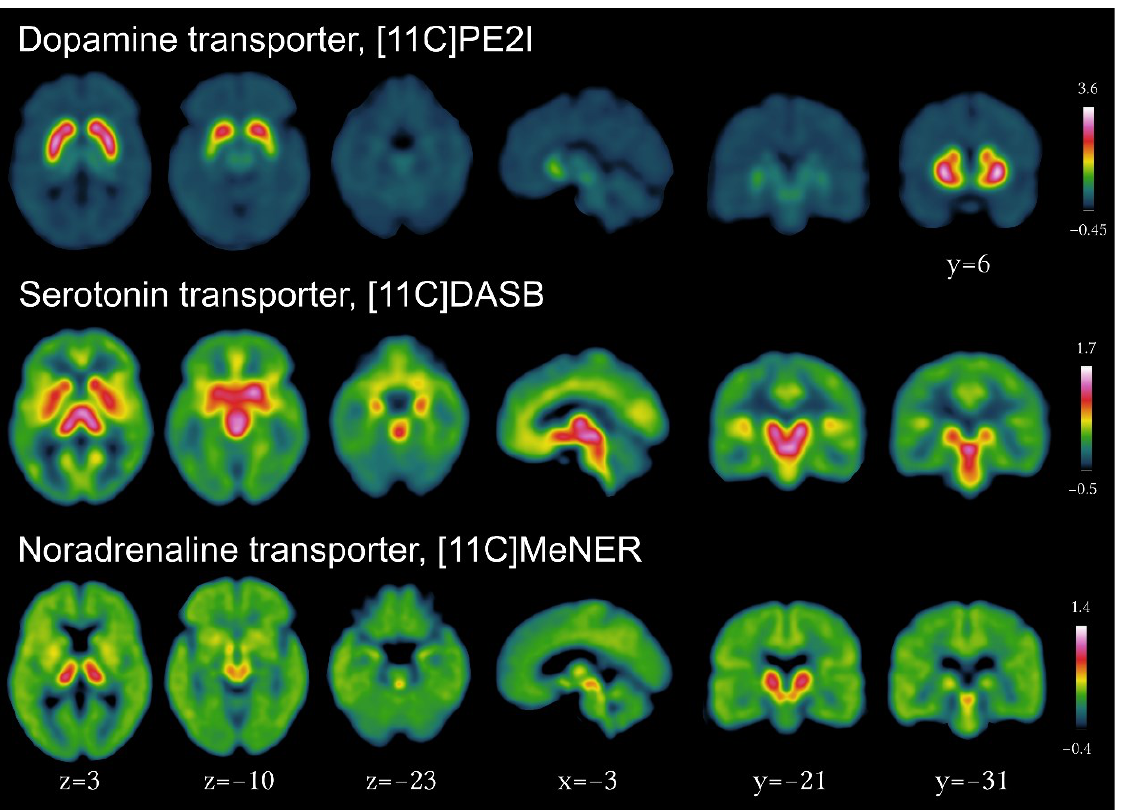
Figure 2. Imaging of the presynaptic dopaminergic, serotonergic and noradrenergic systems using PET tracers for the dopamine transporter ([11C]PE2I), serotonin transporter ([11C]DASB) and noradrenergic transporter ([11C]MeNER, courtesy of Christopher Doppler).